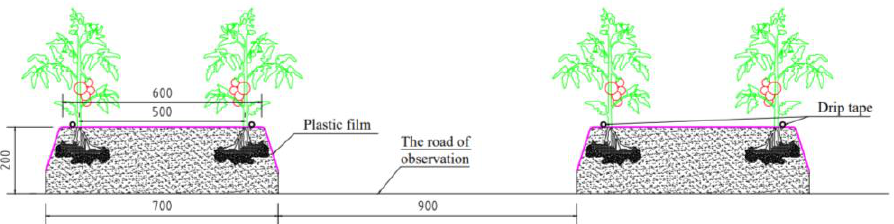
Figure 1. Schematic diagram of planting. Its ridge height was 200 mm, its bottom width was 700 mm, and its top width was 600 mm. Tomatoes were planted on the ridge surface, with a row spacing of 500 mm.